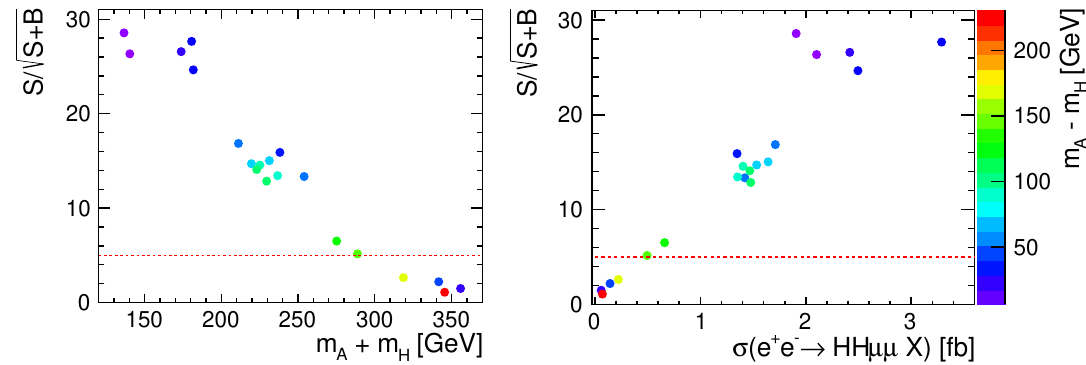
Figure 6 . Expected signi(cid:12)cance of the deviations from the Standard Model predictions observed at 380 GeV CLIC for events with two muons in the (cid:12)nal state ( (cid:22) + (cid:22) (cid:0) ) as a function of the neutral inert scalar mass sum (left) and the production cross-section for the considered signal channel, after pre-selection cuts (right) , for the BPs from table 1. Color indicates the mass splitting between the A and H scalars (right scale applies to both